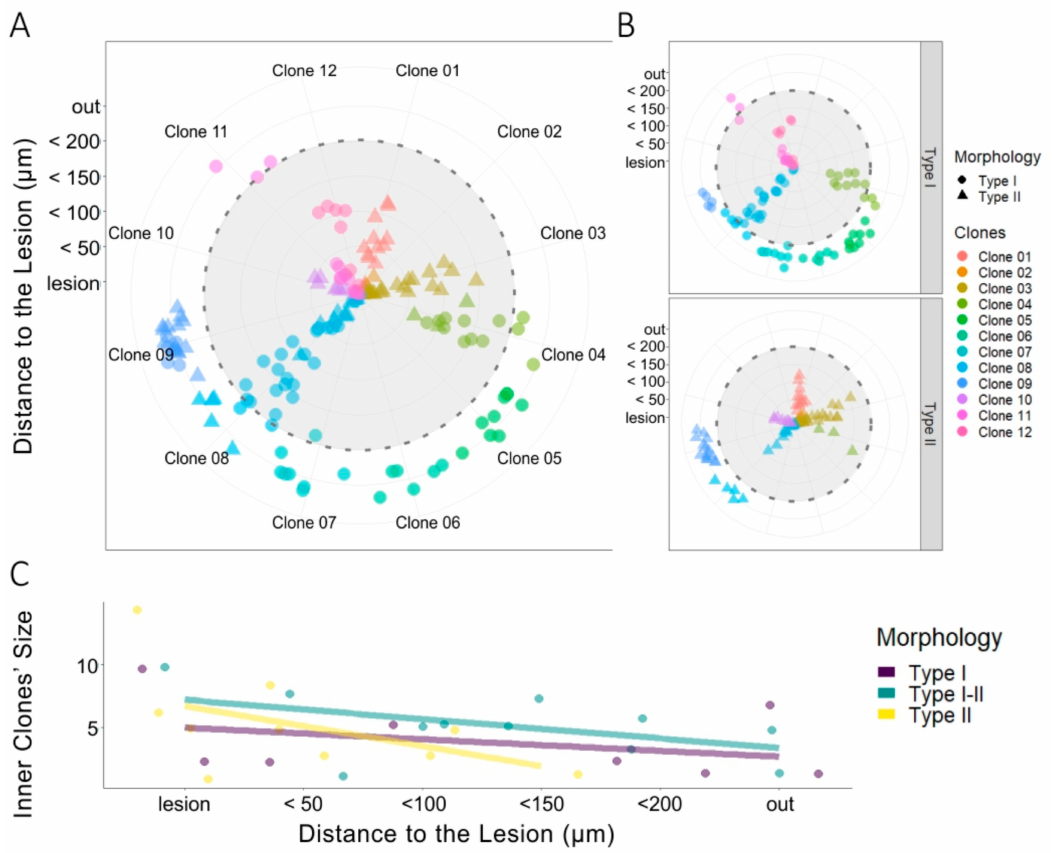
Figure 5. Heterogeneous clonal NG2-glia response to EAE lesions. ( A ) Radial plot of sibling NG2-glia dispersion according to their distance from the EAE-lesion site and the morphology of each cell ( n = 34). The concentric radii define the lesion core area, with the di ff erent perimeters (up to 200 µ m) surrounding that area drawn at an interval of 50 µ m. Lateral quadrants separate type I (dots) and type II (triangles) NG2-glia into two radial plots. Sibling cells have the same color-code. ( B ) Clonally-related type II NG2-glia inner clones (yellow) accumulate close to the lesion core, within the 150 µ m perimeter, and at a higher rate when closer to the lesion core. Type I sibling cells (purple) extended away from the lesion beyond the final 200 µ m perimeter and there were a number of sibling cells distributed evenly at all distances from the lesion. Mixed clones of type I and type II sibling cells (green) tend to accumulate closer to the lesion core, although some clones were located outside of the 200 µ m perimeter. ( C ) Taken together, type II NG2-glia in inner clones are preferentially located within the 150 µ m perimeter